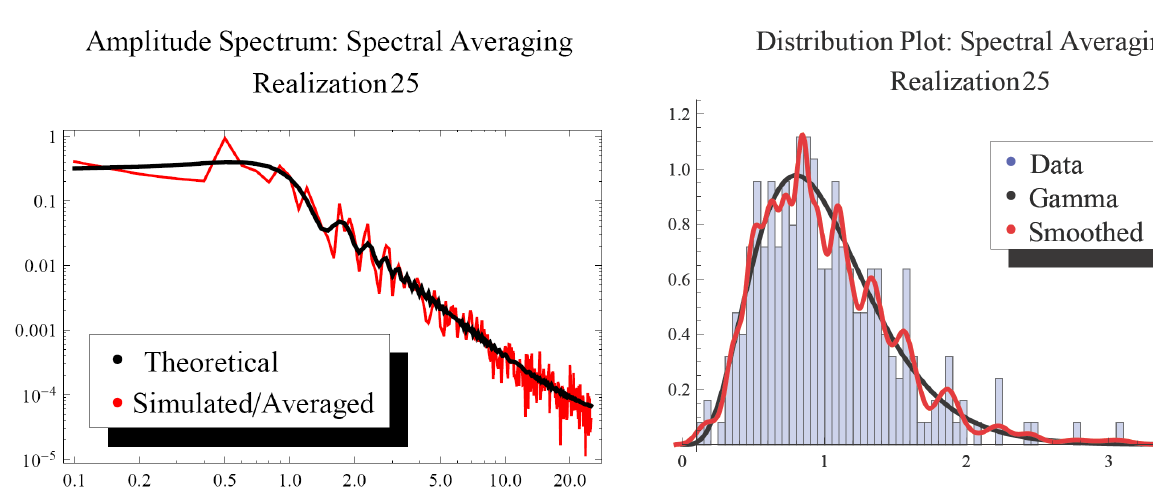
Fig. 19. Averaged and theoretical frequency spectra (in Hz). Five spectra, beginning at realization 25, were averaged.